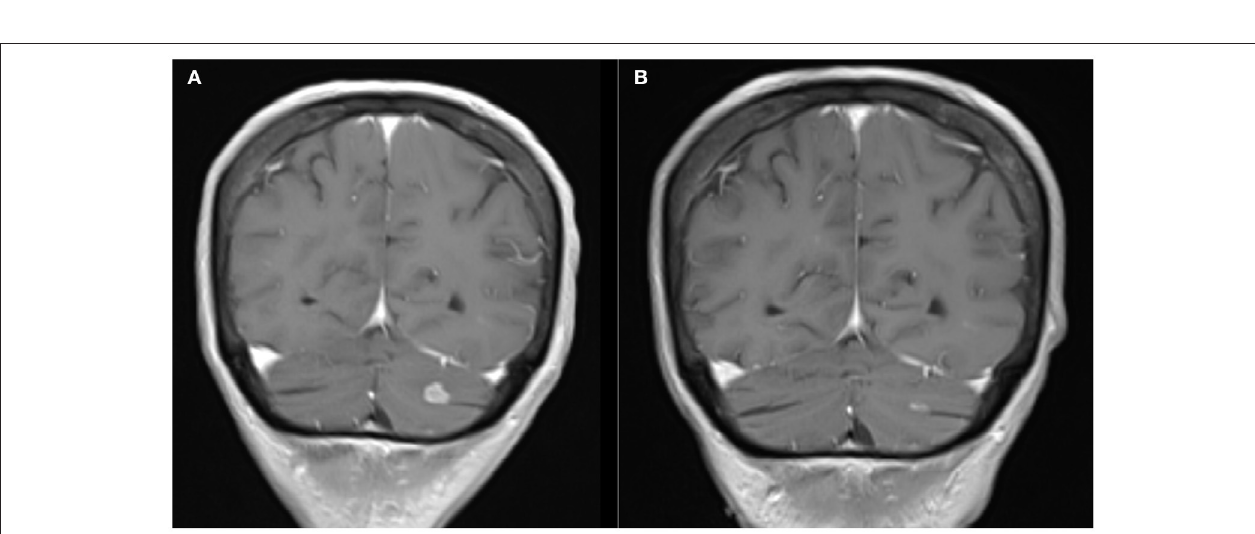
Frontiers in Oncology | www.frontiersin.org